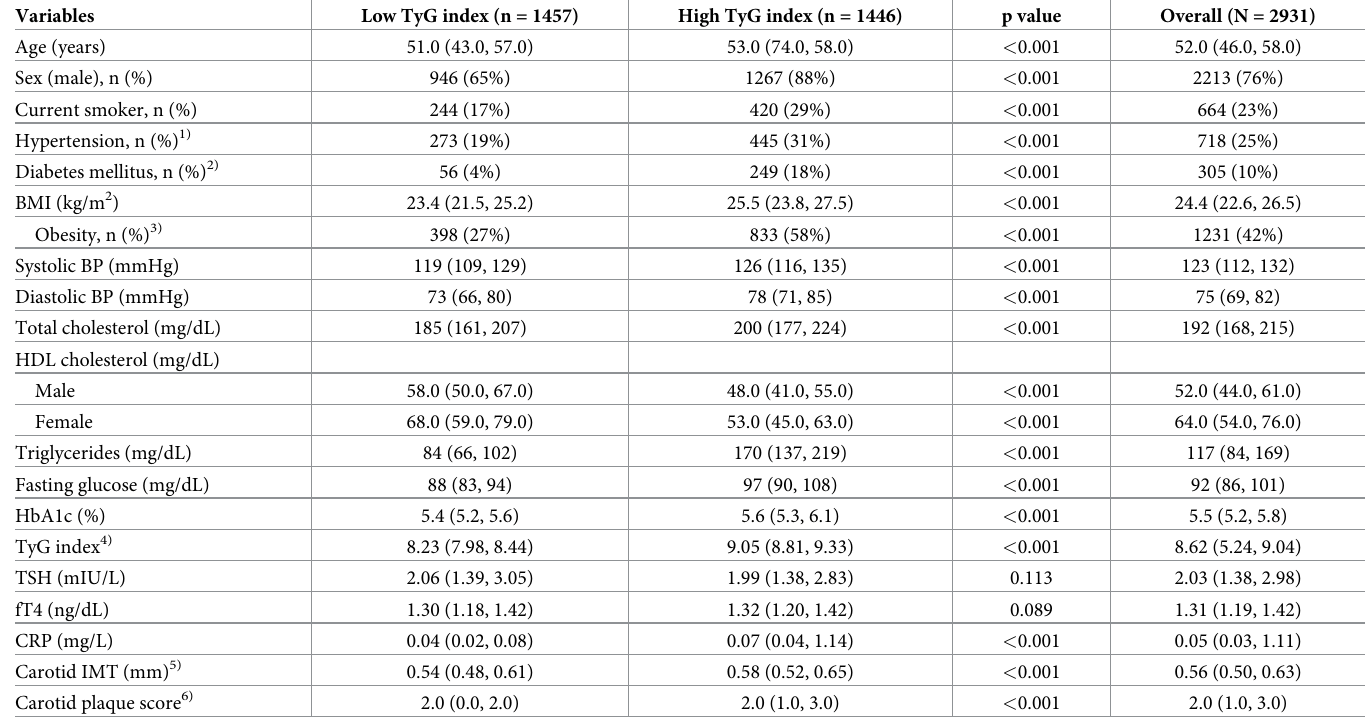
Table 1. Baseline characteristics of participants with respect to the triglyceride-glucose index.